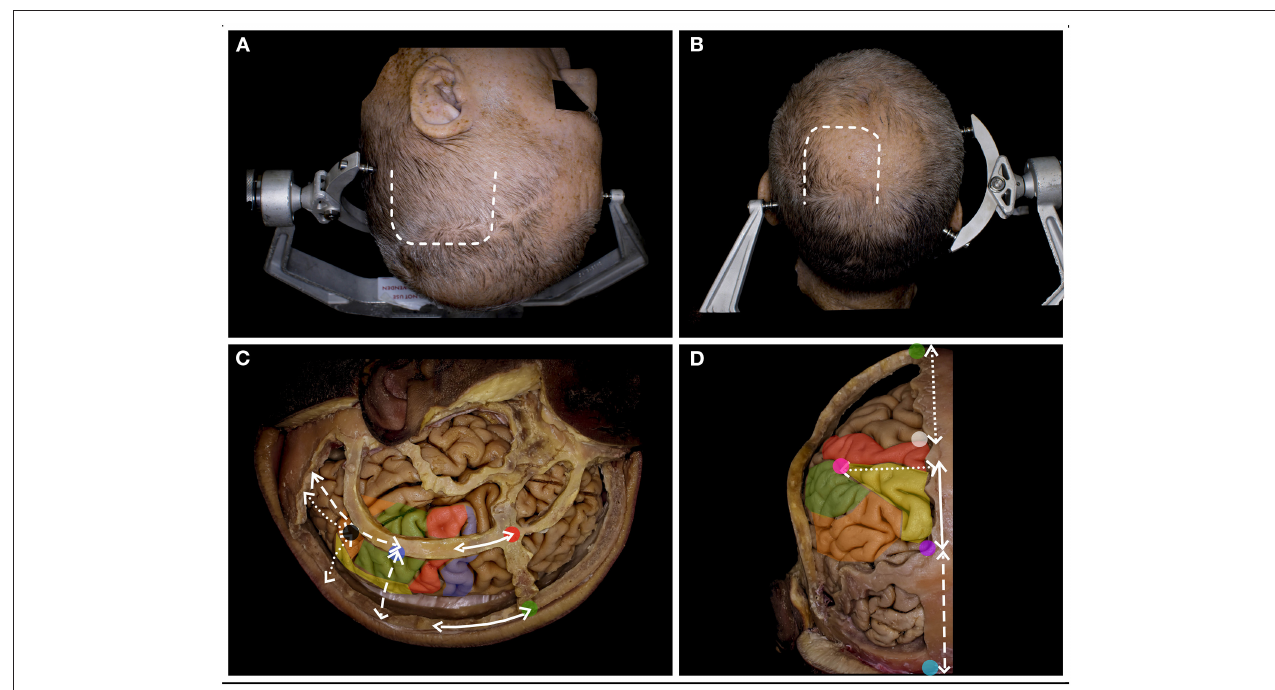
FIGURE 2 | The surgical perspective of the parietal lobe anatomy. (A) For the tumors located within Zones 1, 1 + and 3, below the IPS, the lateral trajectory is preferred, and the long axis of the head is rotated to the contralateral side, being almost parallel to the floor. A u-shaped skin incision (white rectangle) based on the skull base is preferred. (B) For tumors located above the IPS within Zones 2, 2 + , and 4, the superior trajectory is preferred, and the head is positioned in the neutral position. A u-shaped skin incision (white rectangle) with the base at the transverse sinus is preferred. (C) The lateral perspective of the parietal lobe in relation to the craniometric points with marked precentral gyrus (blue), the postcentral (red), the SPL (yellow), the SMG (green) and the AG (yellow). The postcentral gyrus (along the continuous white line) is located ∼ 6.5cm posterior to bregma (green dot) and 4.1cm behind stephanion (red dot). The end of the lateral sulcus within the SMG (blue dot) is identified (along the white rectangle line) ∼ 6.0cm anterior to the lambdoid suture and 6.4cm lateral to the sagittal suture. The end of the superior temporal sulcus within the AG (black dot) was identified (along the white dotted line) ∼ 4.3cm from the lambdoid and 5.0cm from the sagittal suture (6). (D) The posterior/superior perspective of the parietal lobe in relation to the craniometric points. The superior Rolandic point (white dot) is identified ∼ 5.0cm behind bregma, and behind this point, the postcentral gyrus is identified. The parieto-occipital sulcus (purple dot), which marks the posterior border of the parietal lobe, is identified at the level where the lambdoid suture joins the sagittal suture. This point is ∼ 6cm anterior to the inion (light blue) along the midline (white rectangle line). Another 6.0cm anterior to the lambdoid suture along the sagittal suture and 5.0cm lateral and perpendicular to perpendicular to the midline the point (pink) where IPS joins the postcentral sulcus is identified (